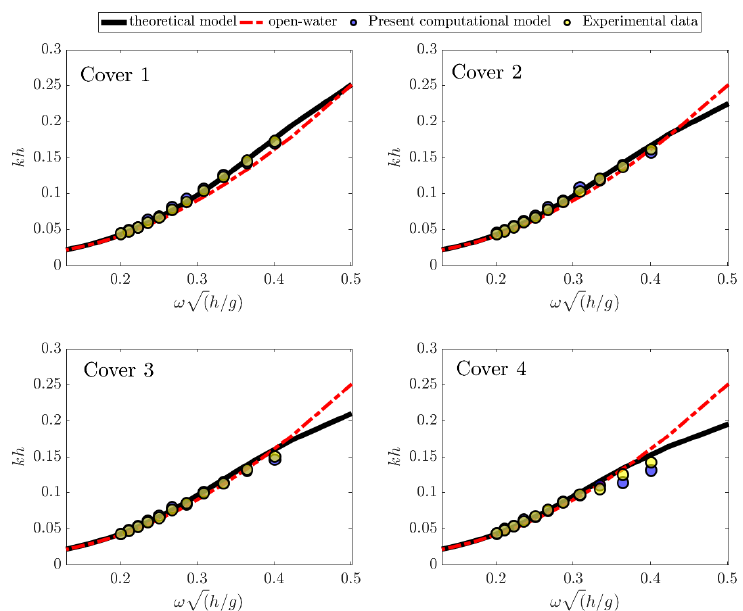
Figure 10. Dispersion curves of waves traveling into uncovered water (dash-dotted red curve) and covered water (markers and solid curves). Experimental and computational data are respectively shown by yellow and blue markers. The black plot shows the predictions of Equation (5). The experimental data are taken from Sree et al. [52].